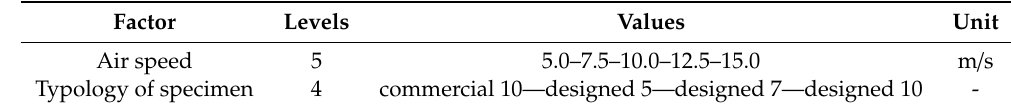
Table 3. ANOVA: factors and levels.